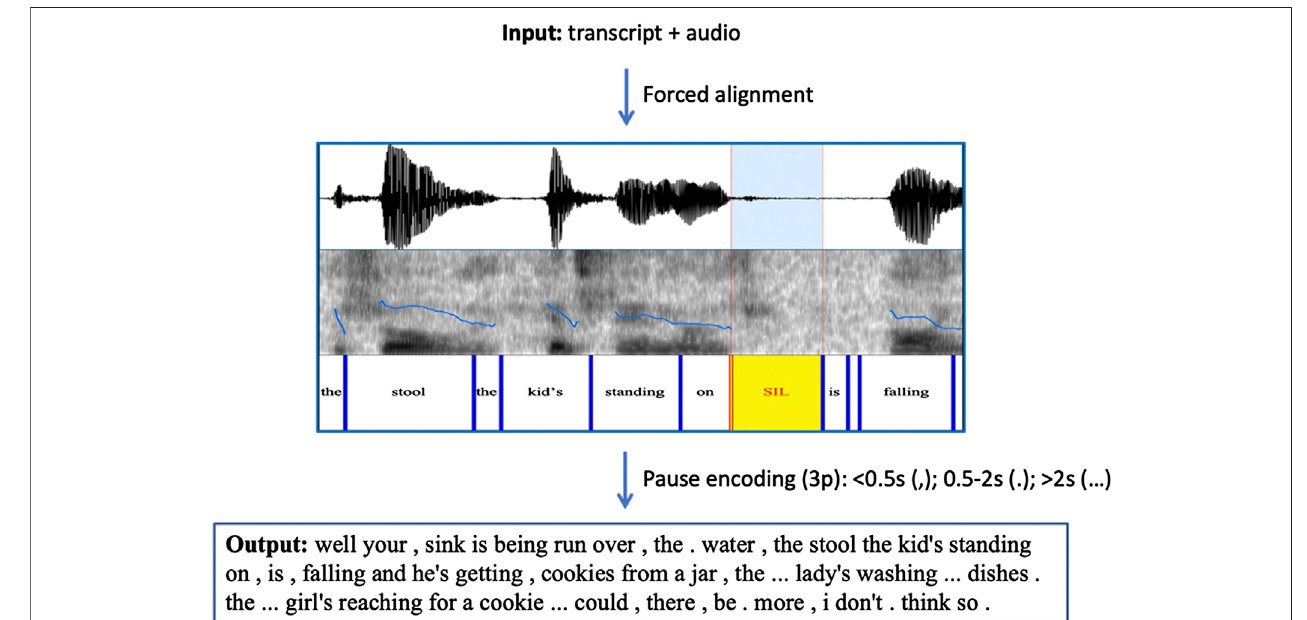
FIGURE 3 | Procedure for pause